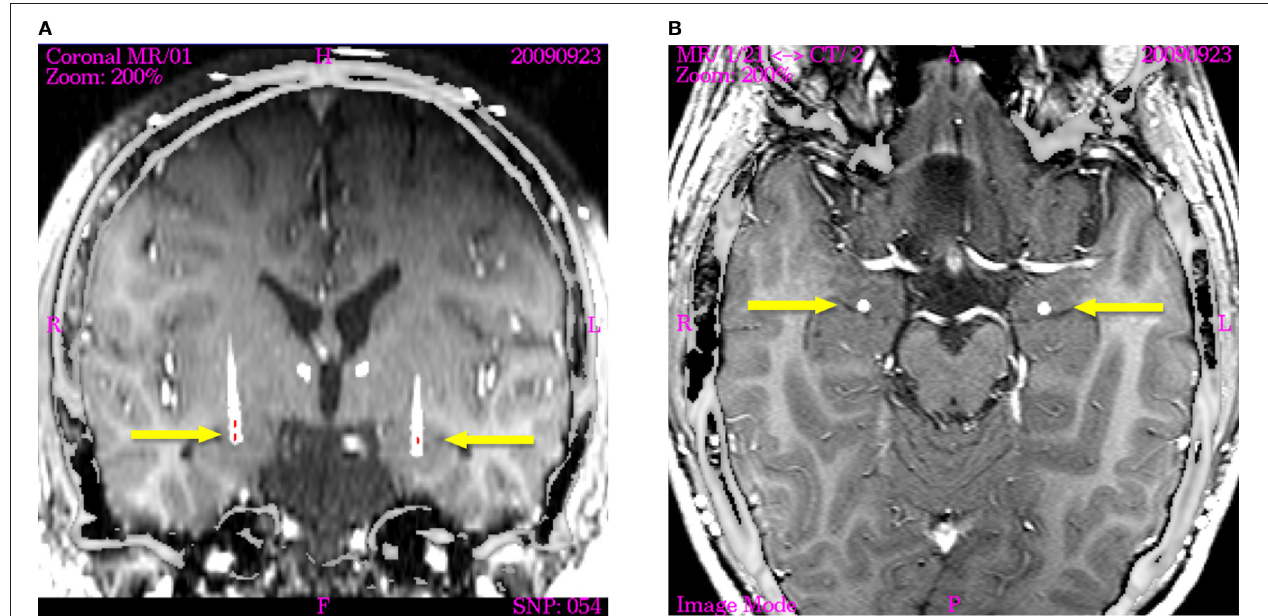
FIGURE 1 | Image fusion of post-operation CT (nine months after implantation) with T 1 -weighted intraoperative planning MRT visualizing the actual electrode position in axial and coronal planes (displayed image size: 145 × 145mm). The active contacts are indicated by red lines in the coronal section. (A) The coronal image is re-sliced in order to show the electrode trajectory in the section plane. Arrowheads indicate the trajectories of the supra-amygdaloid electrodes, which are not